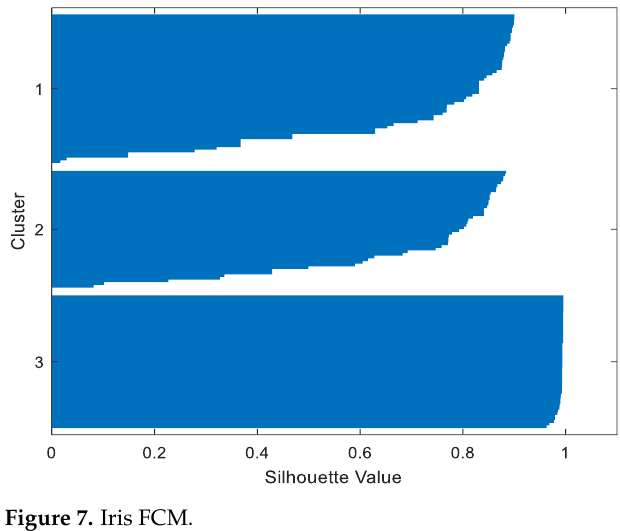
Figure 7. Iris FCM. Figure 7. Iris FCM.